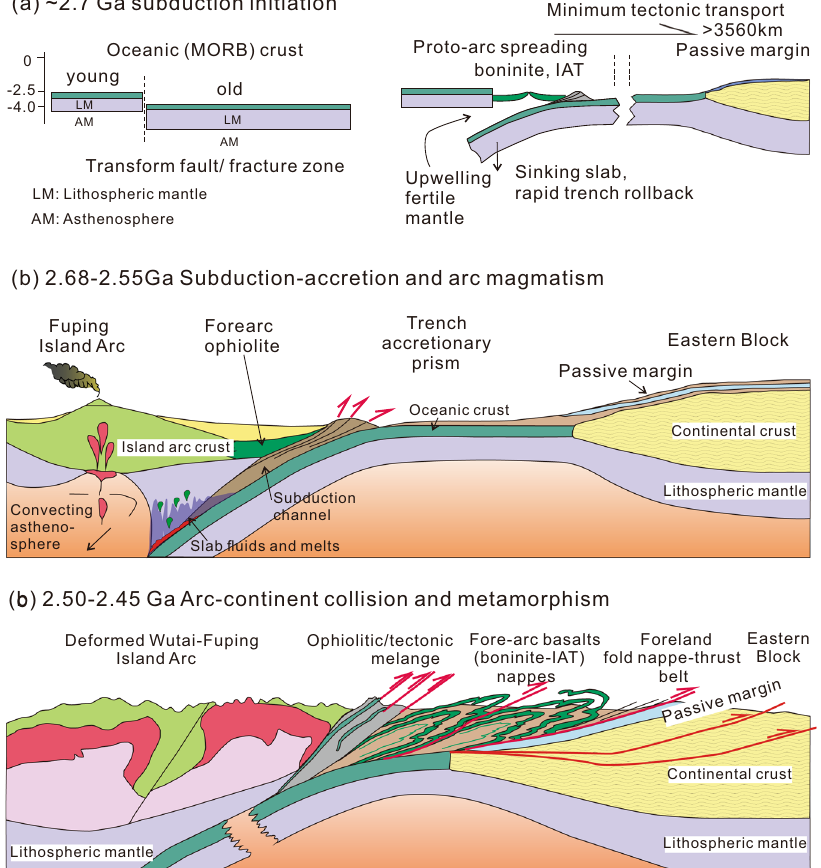
Fig. 10 Schematic cartoon of tectonic evolution. Tectonic evolution of the Zanhuang fold nappe — thrust belt from a subduction initiation at circa 2700 Ma, b arc magmatism during 2692 – 2550 Ma, to c emplacement of the boninite and Buddha nappes over the passive margin on the Eastern Block at 2520 Ma, and metamorphism and foreland basin sedimentation continuing until 2450 Ma. a Adapted from Whattam and Stern 7 with permission from [Springer Customer Service Centre GmbH] [Springer] [Contributions to Mineralogy & Petrology] [The ‘ subduction initiation rule ’ : A key for linking ophiolites, intra- oceanic forearcs, and subduction initiation. Whattam, S. A. & Stern, R. J.] [COPYRIGHT]